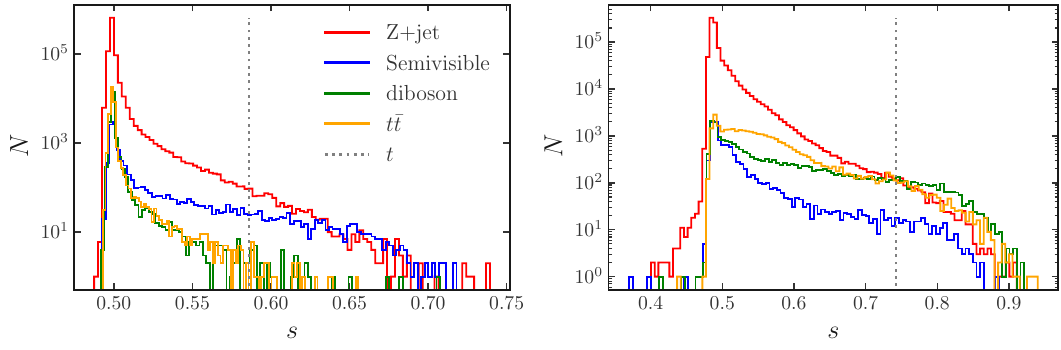
Figure 2 . The absolute number of events in the signal region (Z+jet events in red, semivisible jets in blue, t ¯ t events in orange, diboson events in green) is shown as a function of the classifier score s ∈ [0 , 1] . We have r SR = 3 . 5% and r SR = 2 . 0% and use r CR = r SR and r CR = r SR (left) or V V V V V V t ¯ t t ¯ t t ¯ t r CR = r CR = 0 (right). We also show the threshold value t for (cid:15) CR = 0 . 001 as a vertical line. V V t ¯ t